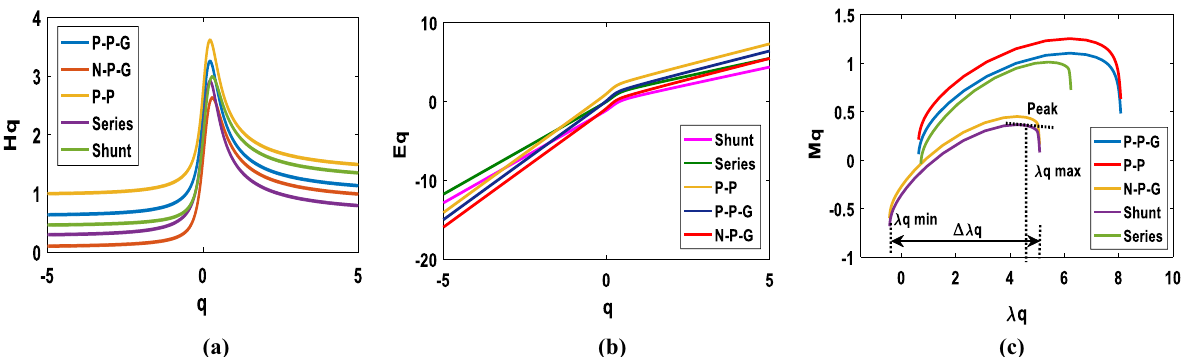
Fig. 18 Analysis ofM-MFDFA features under fault distance variation: a Hurst exponent, b Mass exponent and c Multifractal spectrum